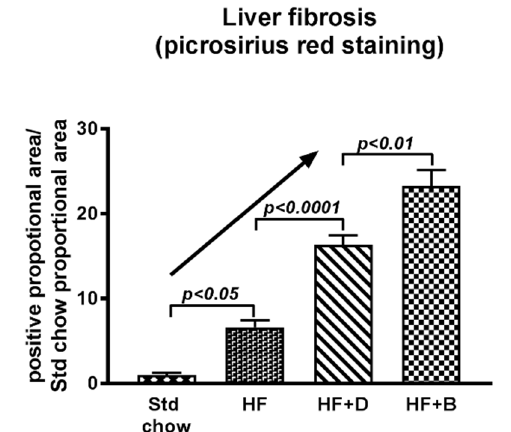
Figure 4. Progression of liver fibrosis during diabetes and high AGE feeding. Liver fibrosis quantified by picrosirius red staining shows that HF diet causes increased fibrosis which is exacerbated in the presence of diabetes. However, high dietary AGEs have worse effect on liver fibrosis. Std chow: standard chow, HF: high fat, D: diabetes, B: standard chow, HF: high fat, D: diabetes, B: baked.